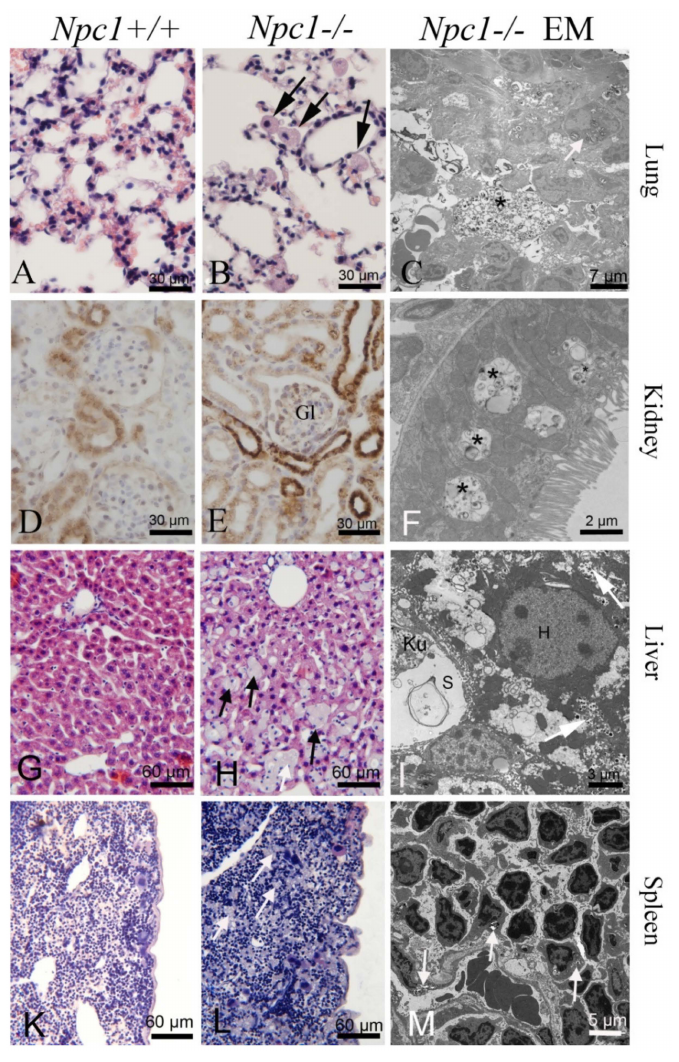
Figure 4. Phenotypes of NPC1 in visceral organs. Left column ( A,D,G,K ): wildtype control animals ( Npc1 +/+ ), middle column: mutant mice ( Npc1 − / − ), right column: mutant animals at the electron microscopic level. The lung presents alveolar edema and emphysema ( B ) and many activated pulmonary macrophages (foam cells, arrows). ( C ) Detailed view of a macrophage filled up with autophagosomes (asterisk) and a normal alveolar cell type II (arrow). In the kidney, cathepsin D immunoreactivity shows increased lysosomal activity in Npc1 − / − mice ( D ), especially in proximal tubules and endothelial cells, as well as podocytes of the glomerulus ( E , Gl). ( F ) Myelin-like deposits (asterisks) in proximal tubular cells. In the liver, numerous pale cells are also visible ( H , arrows). ( I ) Kupffer cells (Ku) in the sinusoids (S) and hepatocytes (H) are filled with autophagosomes (arrows). ( L ) In the spleen, numerous foam cells are seen (arrows). ( M ) Inclusions in endothelial cells and macrophages